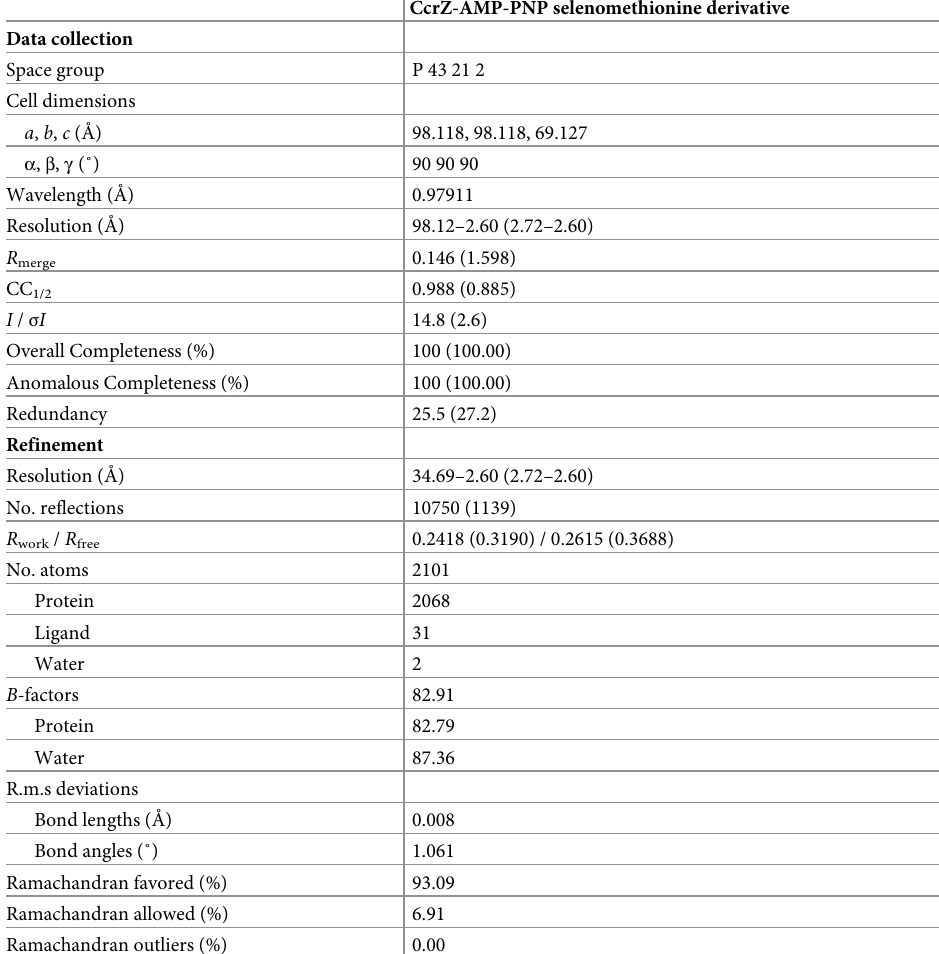
Table 1. Data collection and refinement statistics for SelenoMet-derivatized CcrZ-AMP-PNP